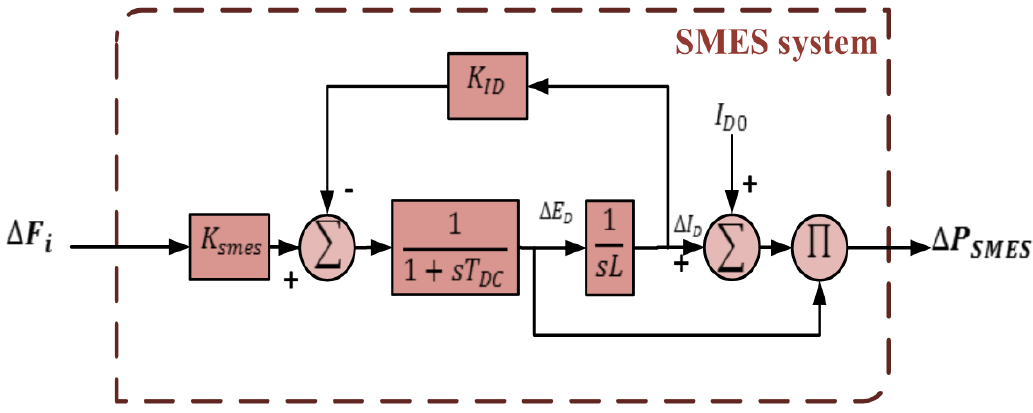
Figure 5. The dynamic model of SMES for frequency stability.